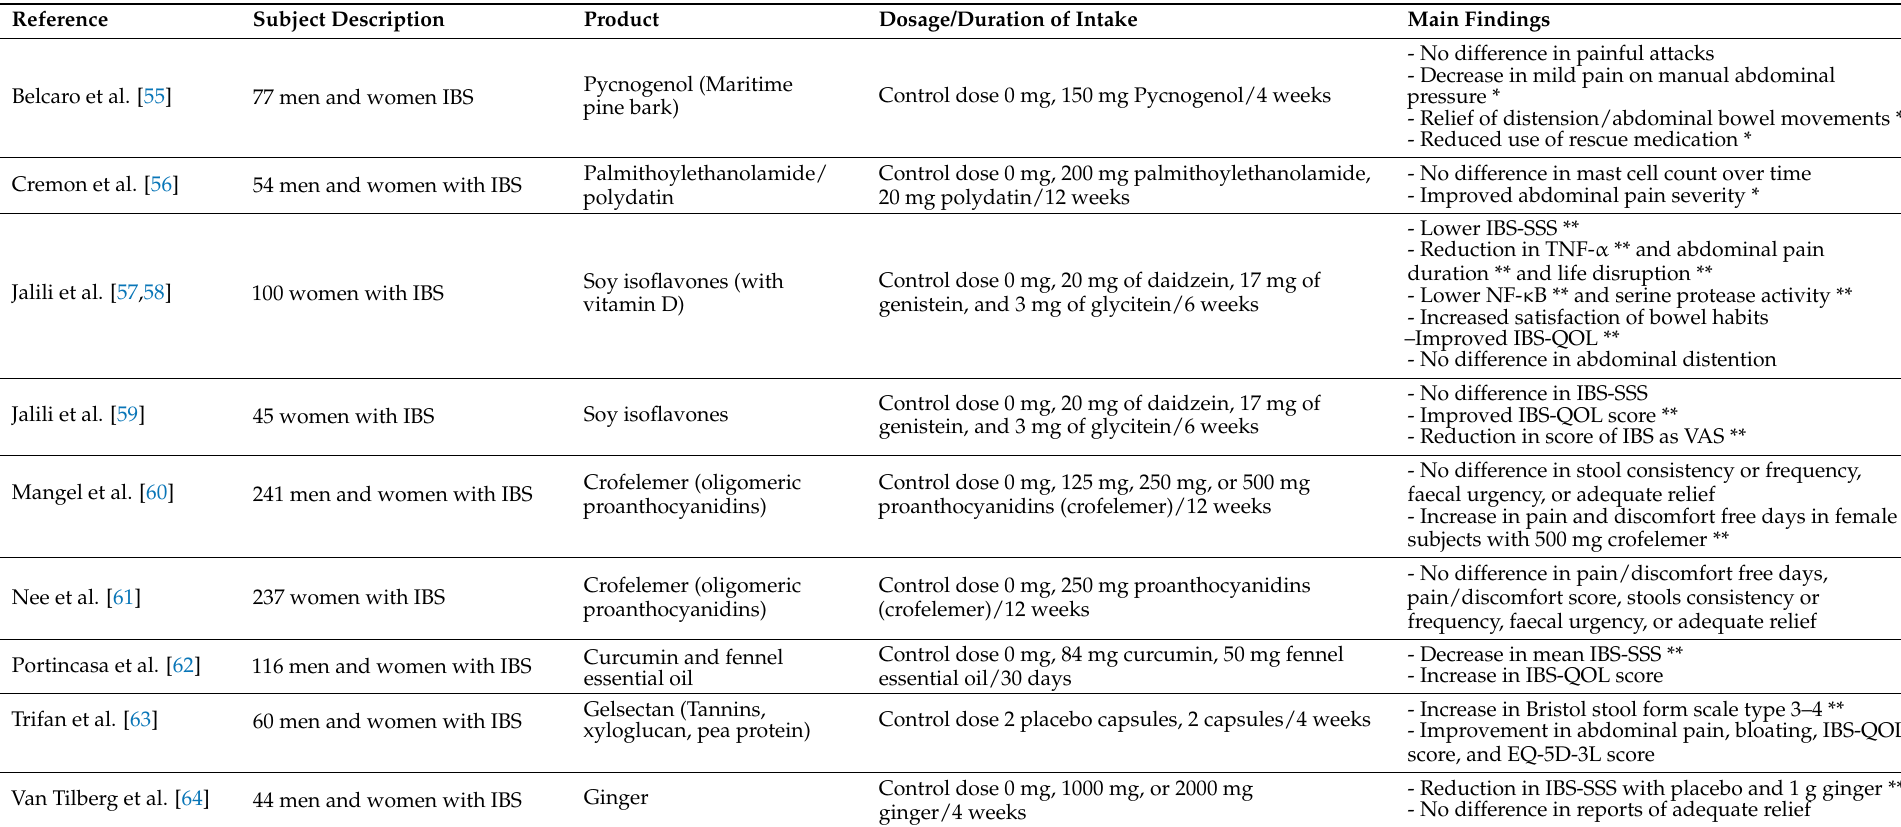
Table 3. Summary of human intervention studies of (poly)phenols in irritable bowel syndrome